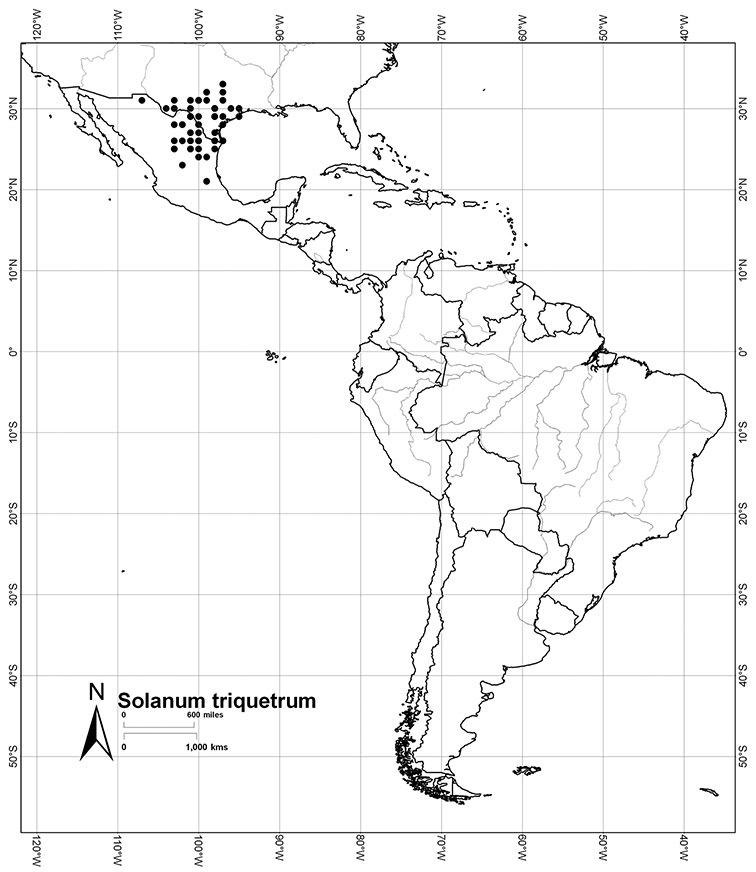
Distribution of Solanum triquetrum Cav.